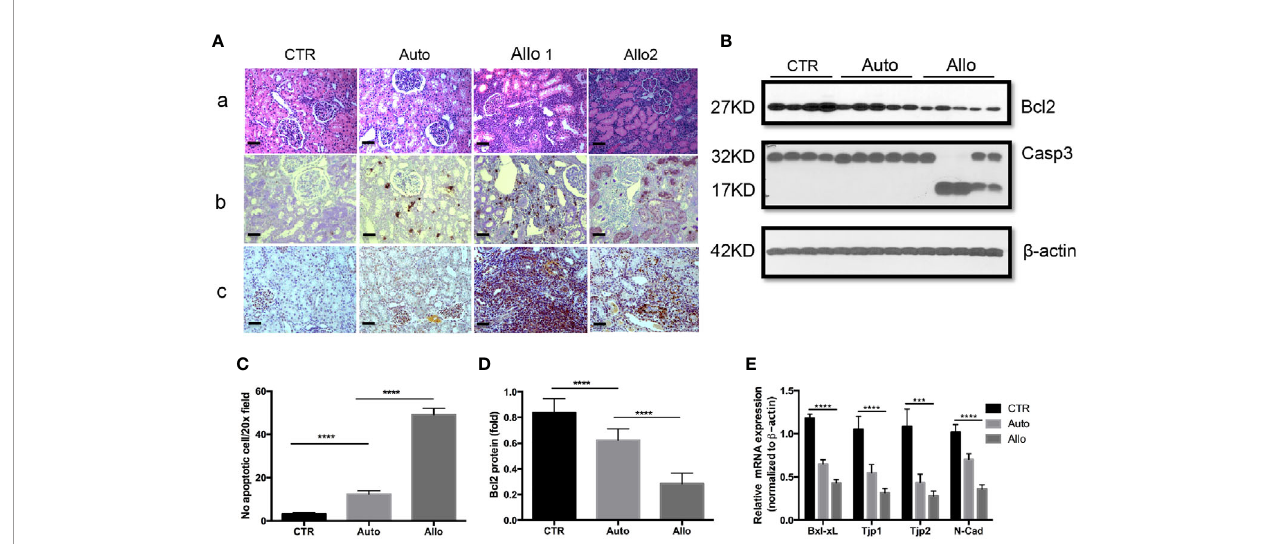
FIGURE 1 | Histology, pathology, and gene expression of kidney tissues. (A) : (a) Histology of a representative control right kidney (CTR), an autotransplant kidney (auto), and 2 Banff level III rejection allografts (allo). N-18 for the CTR group, n = 5 for the auto group, and n = 18 for the allo group. (b) Apoptotic cells of TUNEL positive staining on representative CTR, auto, and allograft. (c) Necrotic cells of cyclophilin A (CypA) positive staining on representative CTR, auto, and allograft. (B) : Gene expression of anti-apoptotic protein Bcl2 and caspase 3 in representative CTR, auto, and allograft. (C) The quantitative average number of apoptotic cells on the 20× microscope view fi eld from random fi ve pictures on each animal tissue. n = 4 for the CTR group, n = 5 for the autotransplant group, n = 7 for the allotransplant group. (D) Quantitative analysis of Bcl2 protein expression in representative graft. (E) Quantitative PCR of Bcl-xL, tight junction proteins 1 and 2, and N-cadherin mRNA in grafts. *** P < 0.001, **** P < 0.0001, one-way ANOVA, auto versus CTR, allo versus auto. The scale bar is 50